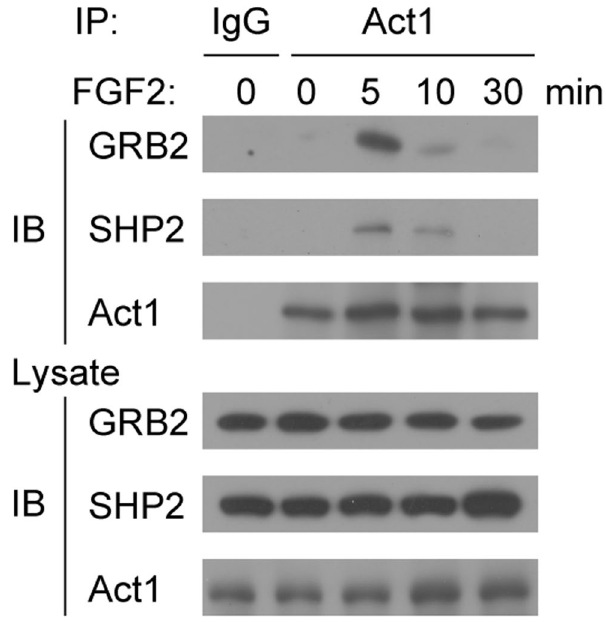
Figure 7. Act1 is recruited to Grb2 complex in FLS cells after FGF2 stimulation. Co-immunoprecipitation of cell lysates from human primary FLS cells. Cells were left untreated (0) or treated for the indicated time points with FGF2 (50 ng/ml). Whole cell lysates were immunoprecipitated with anti-Act1 and immunoblotted with the indicated antibodies. Data are representative of two independent experiments.